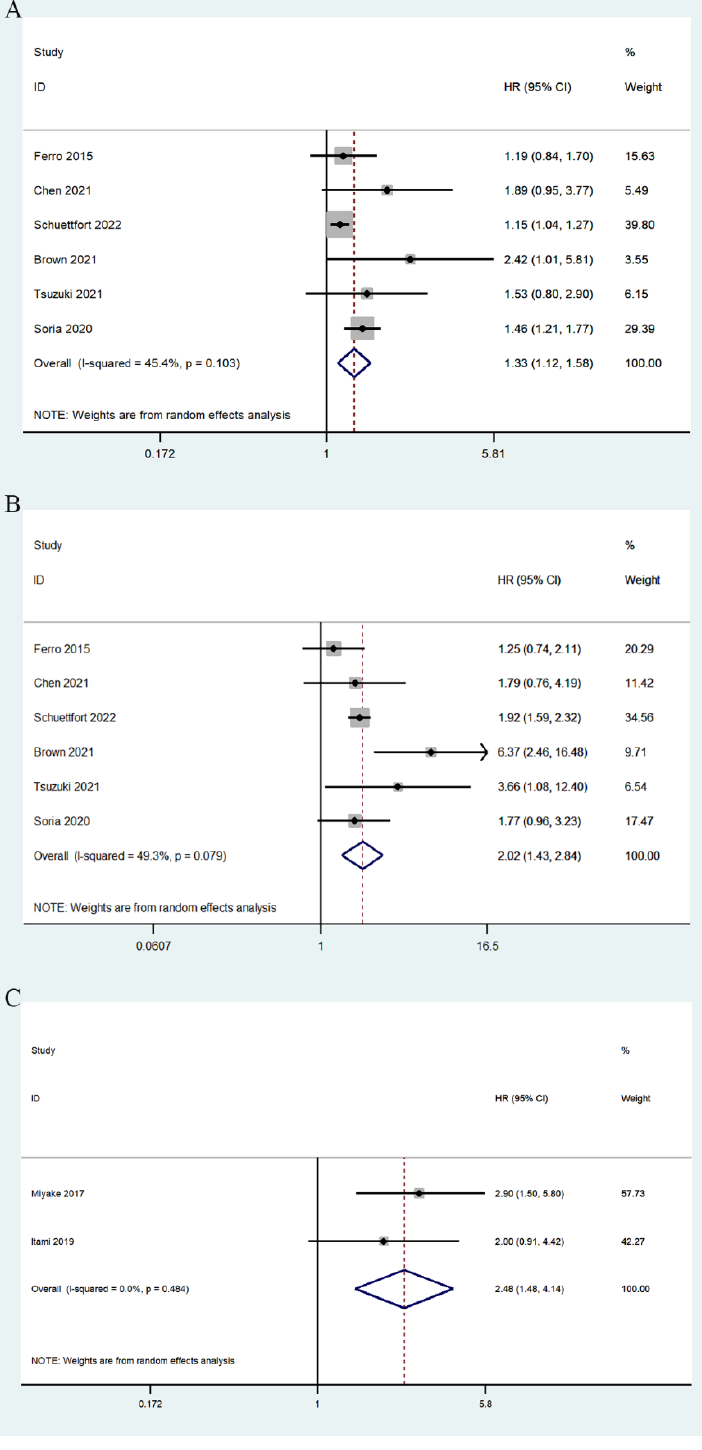
Figure 3. Forest plots of relationship between mGPS and OS in patients with urothelial